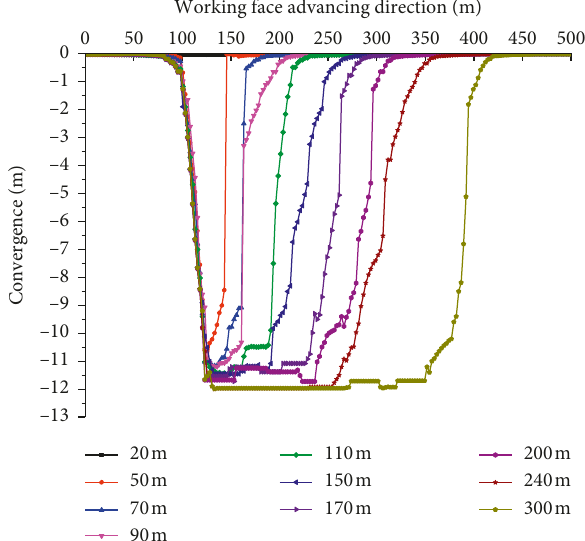
Figure 4: Subsidence curves of the inferior key strata.